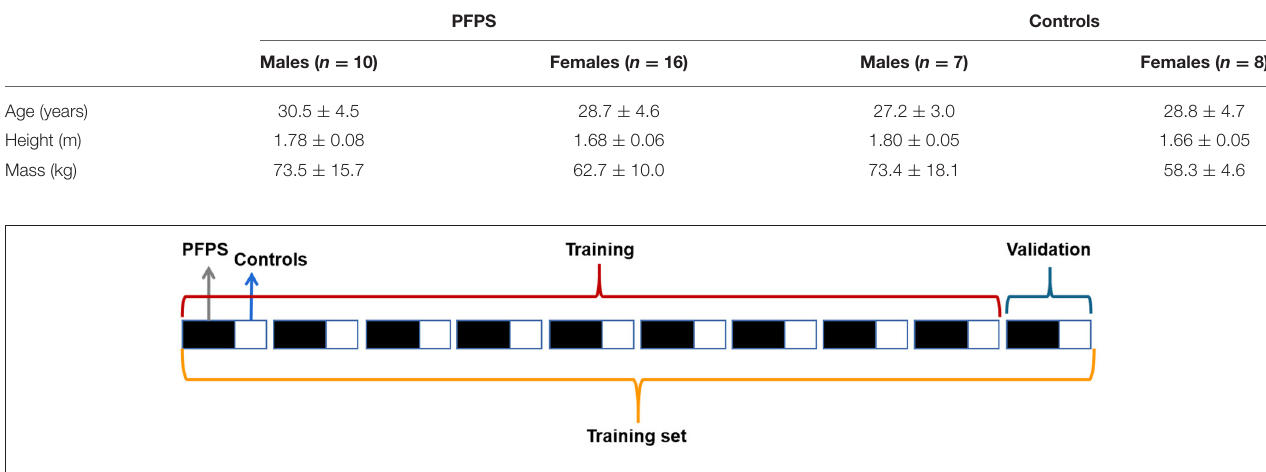
FIGURE 1 | Data partition in 10-fold